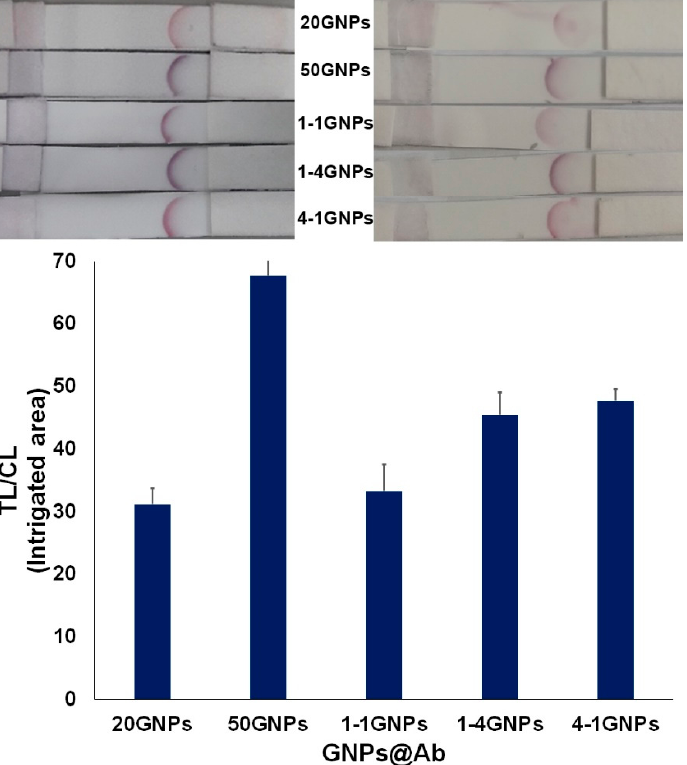
Figure 8. Ratio of the test line intensity ( TL ) divided by the control line intensity ( CL ) corresponding to each strip of particles immobilized on the conjugate pad for the detection of BSA molecules ( 4 mg mL − 1 ). (n ≥ 3). (4 mg mL − 1 ). (n ≥